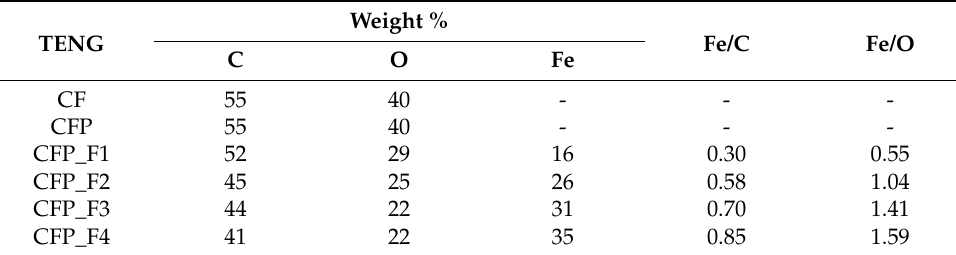
Figure 2. SEM images of CF, CFP, and CFP_F1 ‐ F4 samples. Table 2. EDX Element analysis of the CF and CFP samples.